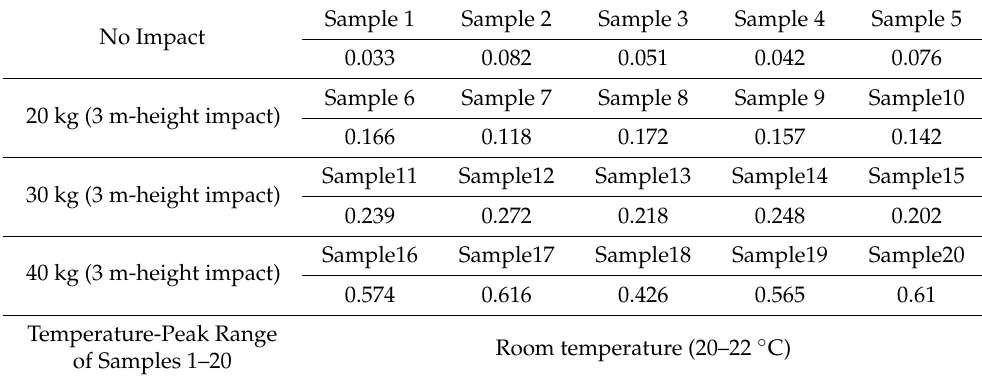
Table 6. The normalized shock-damage data of unburned concrete samples.